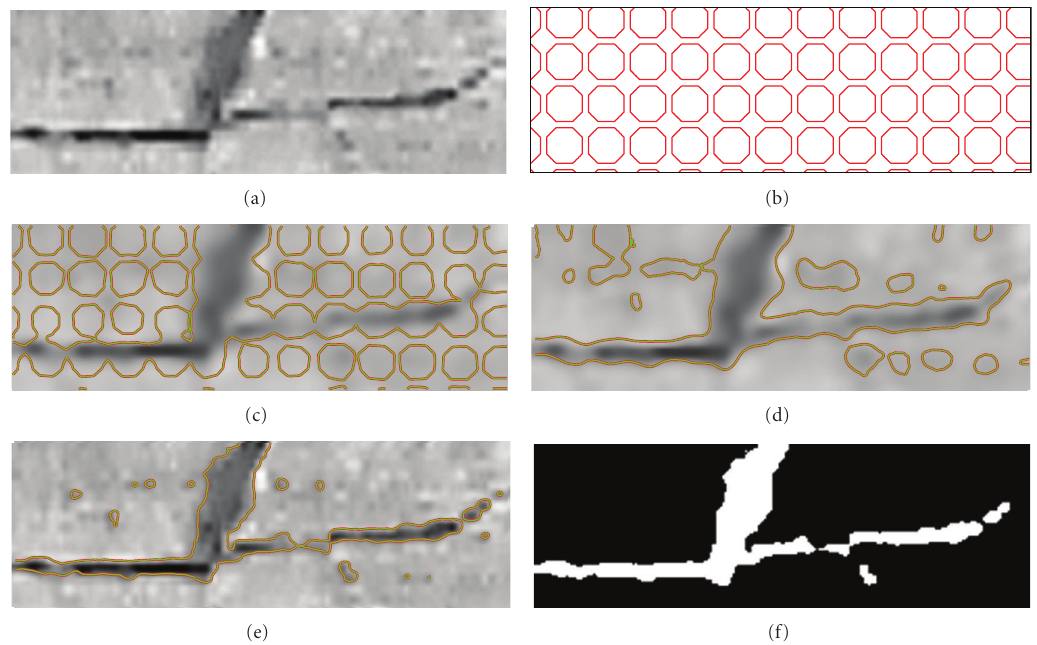
Figure 8: Crack detection using the level set-based active contour method: (a) the selected ROI, also shown in Figure 6; (b) the initialized contours; (c) and (d) intermediate detection results; (e) the converged result; (f) the cleaned detection result with contours for the air pockets